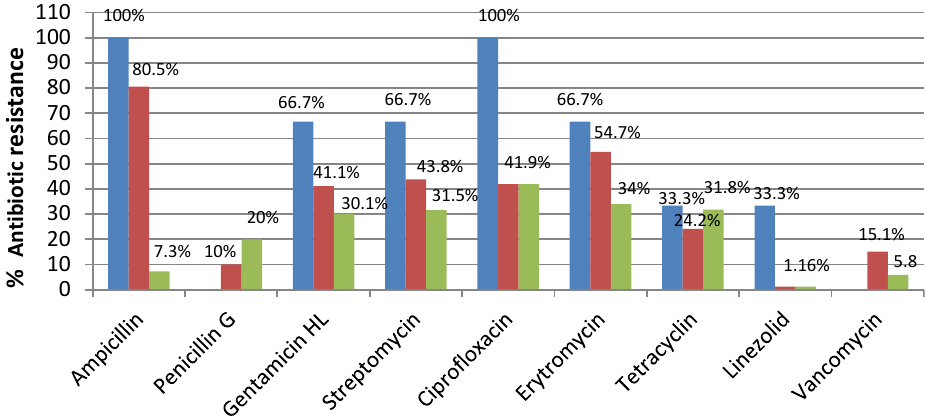
Figure 2. The distribution of antibiotic resistance in the strains of E. gallinarum , E. faecium , and E. faecalis and from Galati, Romania.